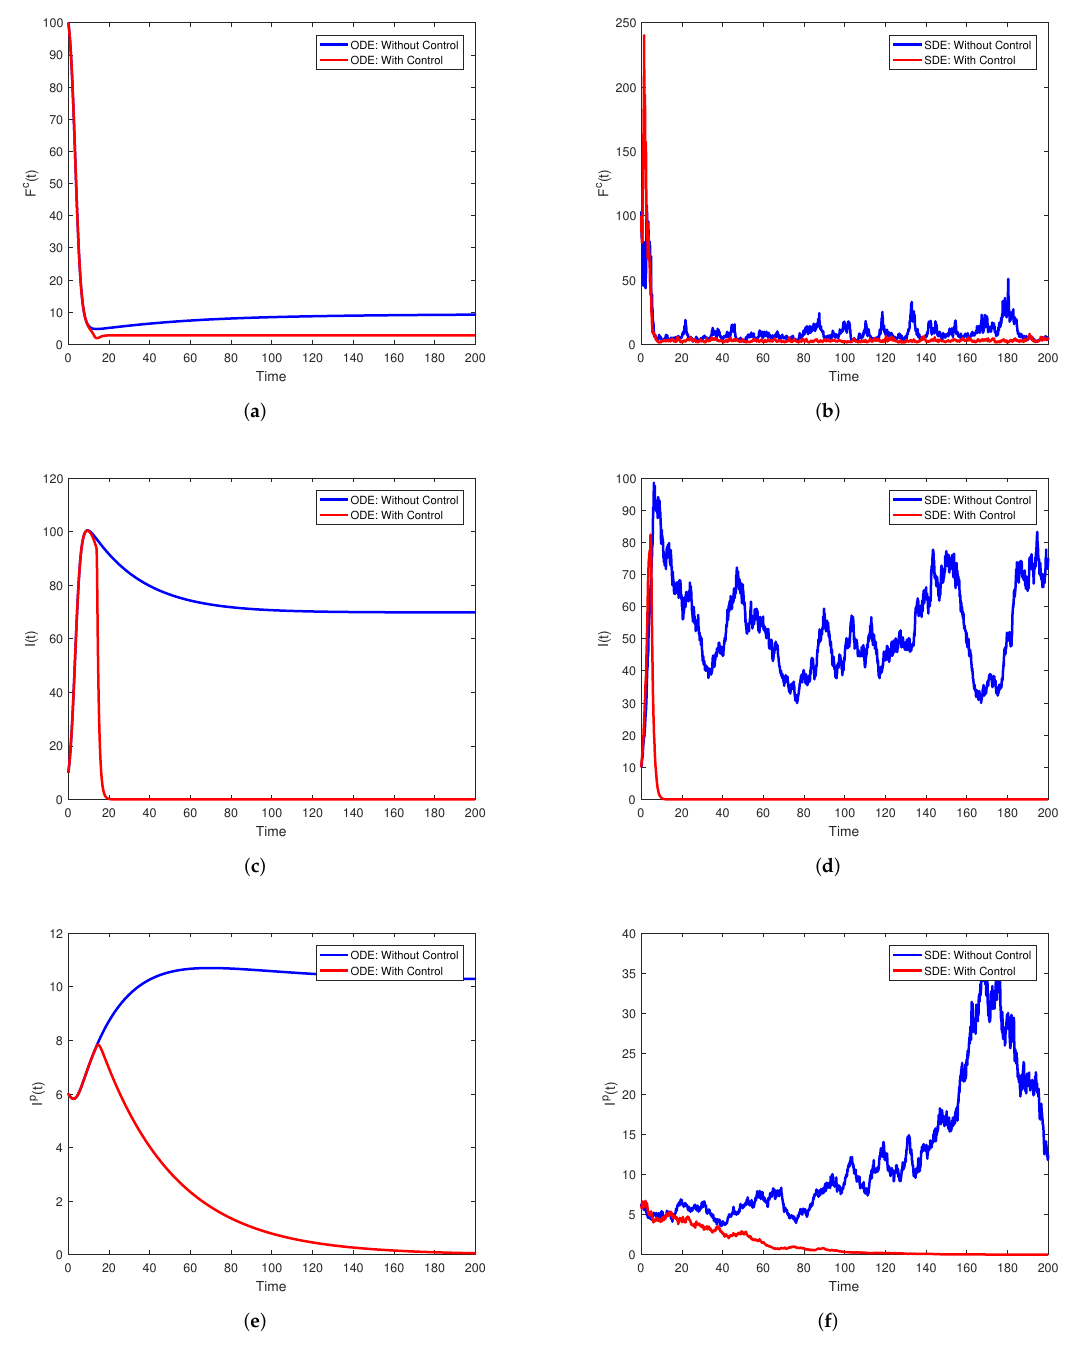
Figure 4. Simulations of ( F c ( t ) , I ( t ) , I P ( t )) for the stochastic model (1) with its corresponding deter- ministic version, both with and without control. ( a ) F c ( t ) in the case of the deterministic model both with and without control. ( b ) F c ( t ) in the case of the stochastic model both with and without control. ( c ) I ( t ) in the case of the deterministic model both with and without control. ( d ) I ( t ) in the case of the stochastic model both with and without control. ( e ) I P ( t ) in the case of the deterministic model both with and without control. ( f ) I P ( t ) in the case of the stochastic model both with and without